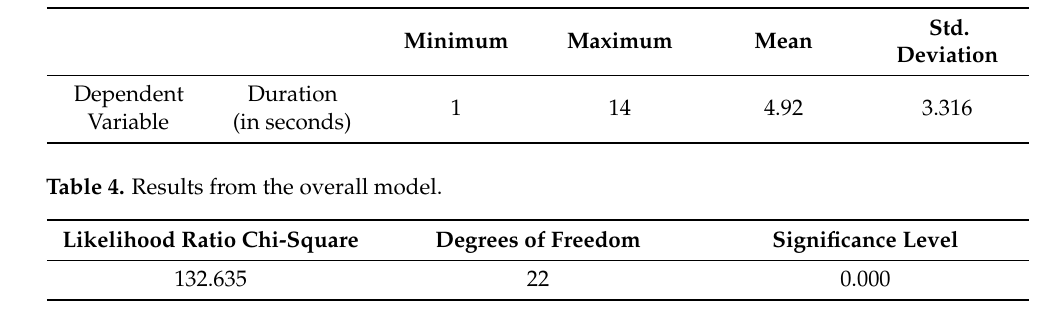
Table 3. Dependent variable statistics.